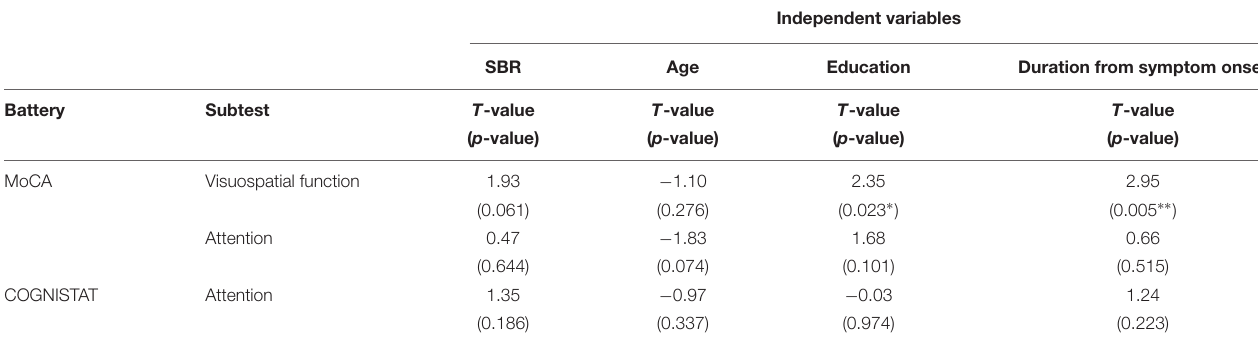
TABLE 4 | Multiple regression analysis for cognitive assessments that had significant Spearman correlation coefficients with